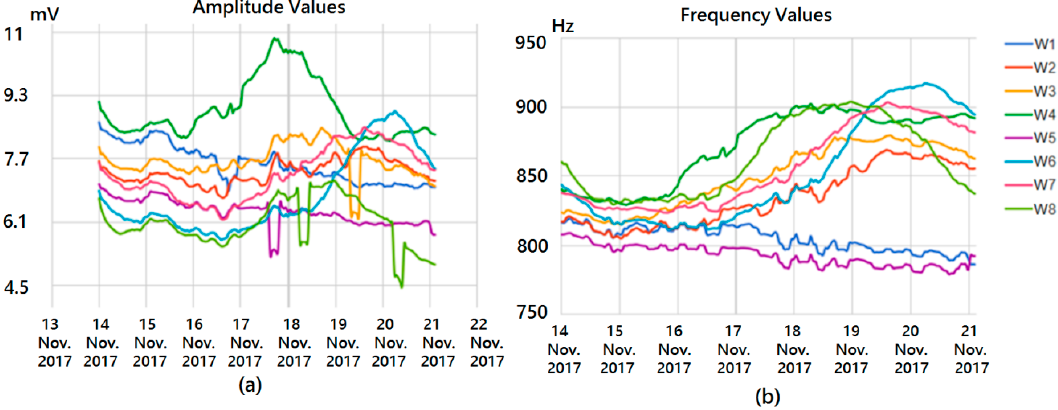
Figure 8. Real-time visualization on the web interface for seven days culturing N2A cells. ( a ) amplitude and ( b ) frequency values. Visualization on the website. All data are presented in real-time. The amplitude values are in millivolts and the frequency in Hertz. Each of the wells from the experiment were seeded at different density levels: empty wells containing only medium (W1, W5), 2500 cells (W2, W6), 5000 cells (W3, W7) and 10,000 cells (W4, W8).